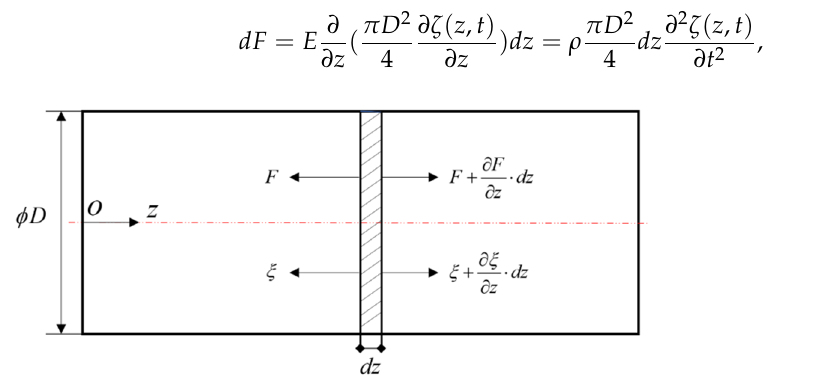
Figure 4. Simplified model of transducer vibration.